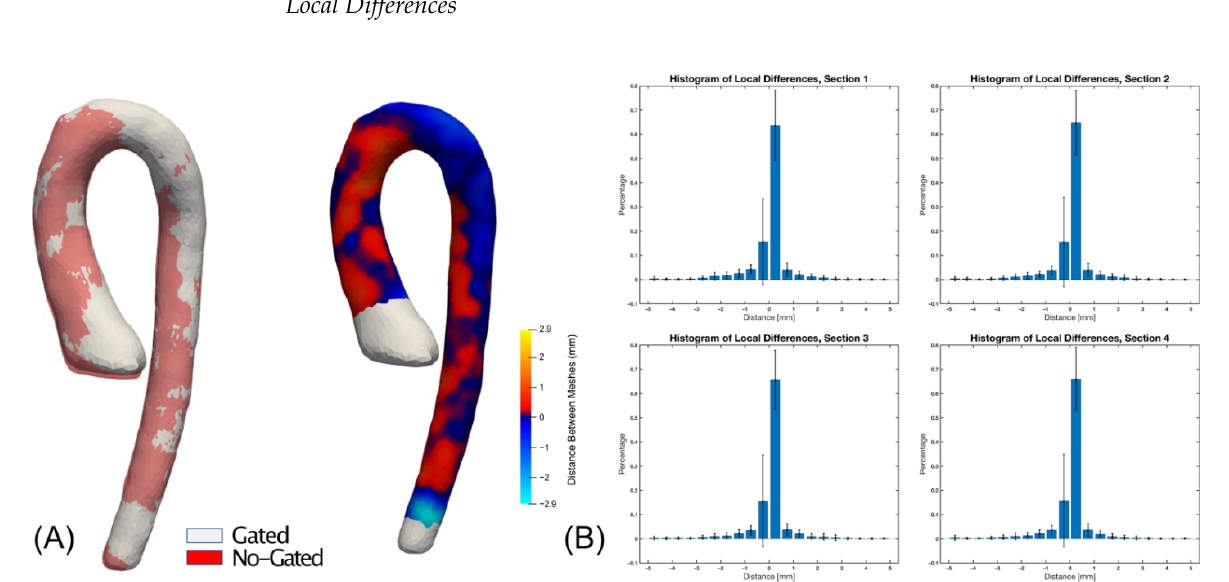
Figure A1. The Bland–Altman plots for comparing the hemodynamic parameters computed in this research, with and without self-gating: velocity; WSS; WSSA; WSSC; vorticity; viscous dissipation; energy loss; and kinetic energy. The average axis of the Bland–Altman plots corresponds to the av- erage of the data with self-gating (SG) and without self-gating (NG), 𝐴𝑣𝑒𝑟𝑎𝑔𝑒 = (cid:3020)(cid:3008)(cid:2878)(cid:3015)(cid:3008) ence axis corresponds to the difference between the data with self-gating (SG) and without self- gating (NG), 𝐷𝑖𝑓𝑓𝑒𝑟𝑒𝑛𝑐𝑒 = 𝑆𝐺 − 𝑁𝐺 . The difference axis shows the lines plotting the mean ± 1.96 times the standard deviation, and the zero value for comparison purposes.